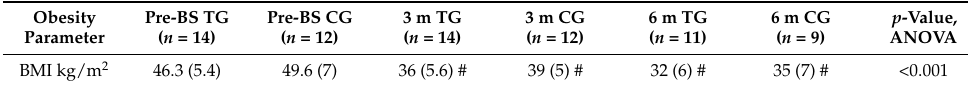
Table 2. Weight loss after bariatric